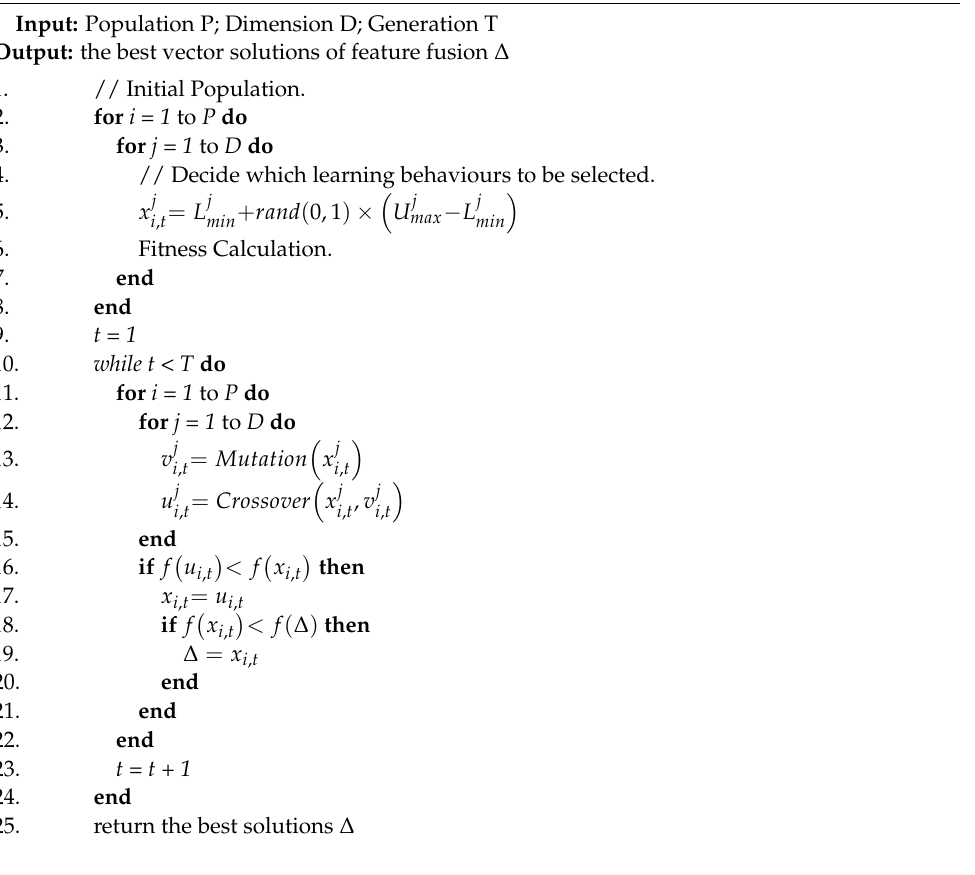
Algorithm 1: FGDEM: Fine-grained differential evolution